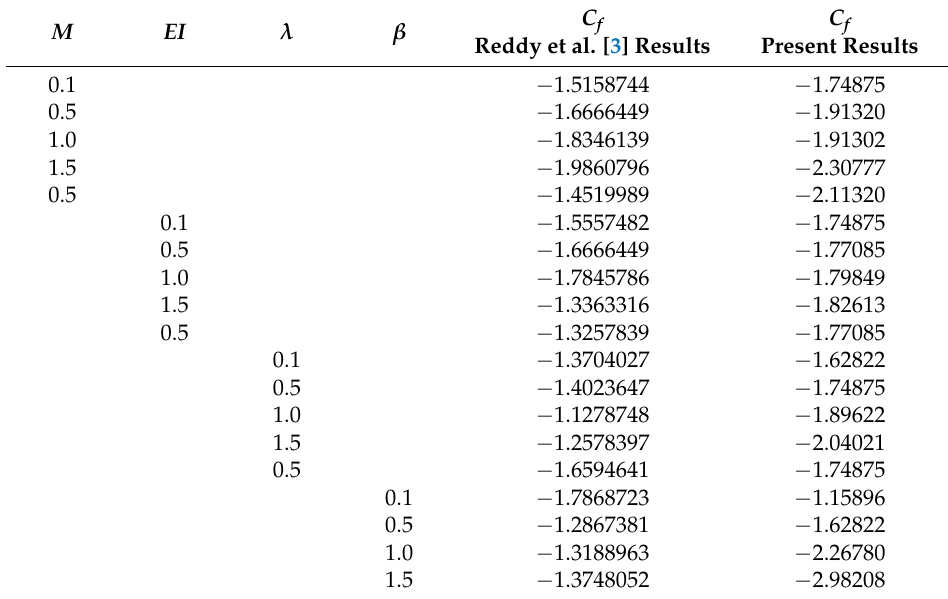
Table 1. Variation in Skin-Friction Coefficient of various parameters where ω = Rd = Pr = Nt = Nb = Sc = δ = 0.1.